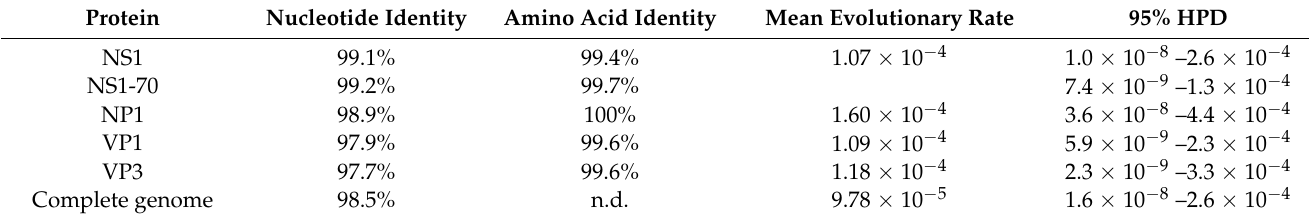
Figure 2. The evolutionary history was inferred by using the maximum likelihood method and general time reversible model. A discrete gamma distribution was used to model evolutionary rate differences among sites. The scale bar indicates the proportion of nucleotide substitutions; the numbers are bootstrap values determined for 1000 iterations (only values above 70% are shown). Nucleotide sequences of HBoV1 strains were obtained from the GenBank and used to construct alignments and phylogenetic trees. As outgroups, sequences belonging to HBoV2, HBoV3 and HBoV4 previously described in the literature were included in the analysis. Croatian sequences have the prefix HR and are indicated in bold; only sequences with unique nucleotide residues were used for phylogenetic analysis, while the numbers in brackets indicate number of strains with identical sequences detected in this study. Table 2. Nucleotide identity percentages and rates of substitution of four genes of HBoV1 strains included in this study. Protein Nucleotide